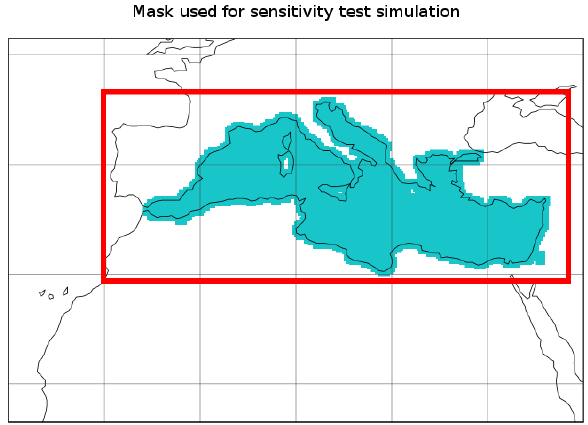
Figure 10. Map of the mask used to cancel the anthropogenic emis- sion in the sensitivity test simulation in cyan and the budget domain in